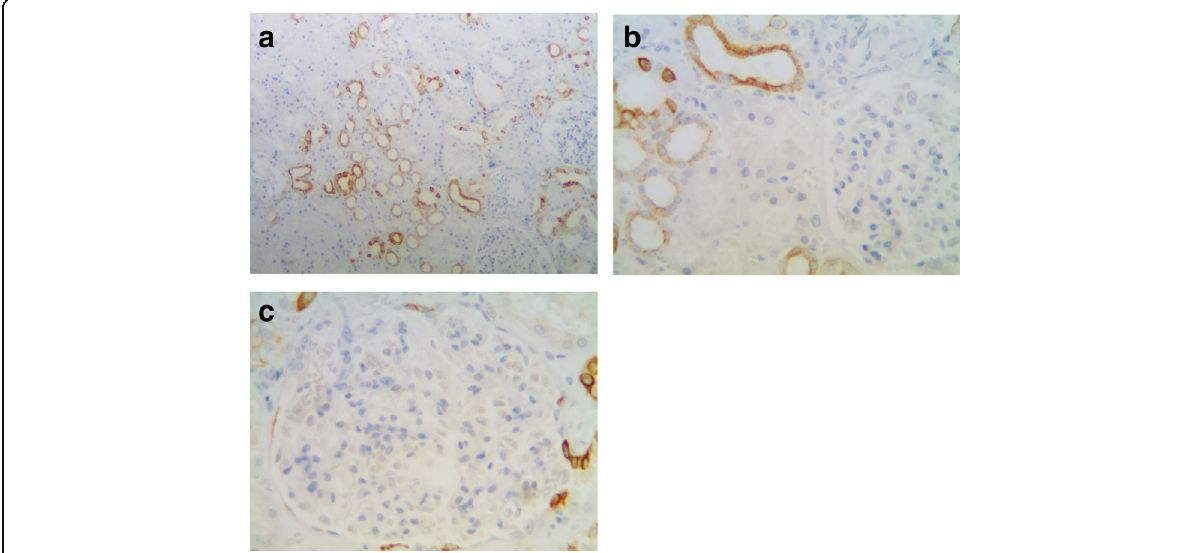
Fig. 1 TGR5 staining in normal renal cortex. a TGR5 is strongly expressed in the distal convoluted tubule, thin loop of Henle, and collecting duct (100X). b Absent or only minimal focal weak staining is observed in the proximal convoluted tubular cells (arrow, 400X). c In the glomeruli, TGR5 expression is not identified in the glomerular tufts while staining is present focally in the parietal epithelial cells